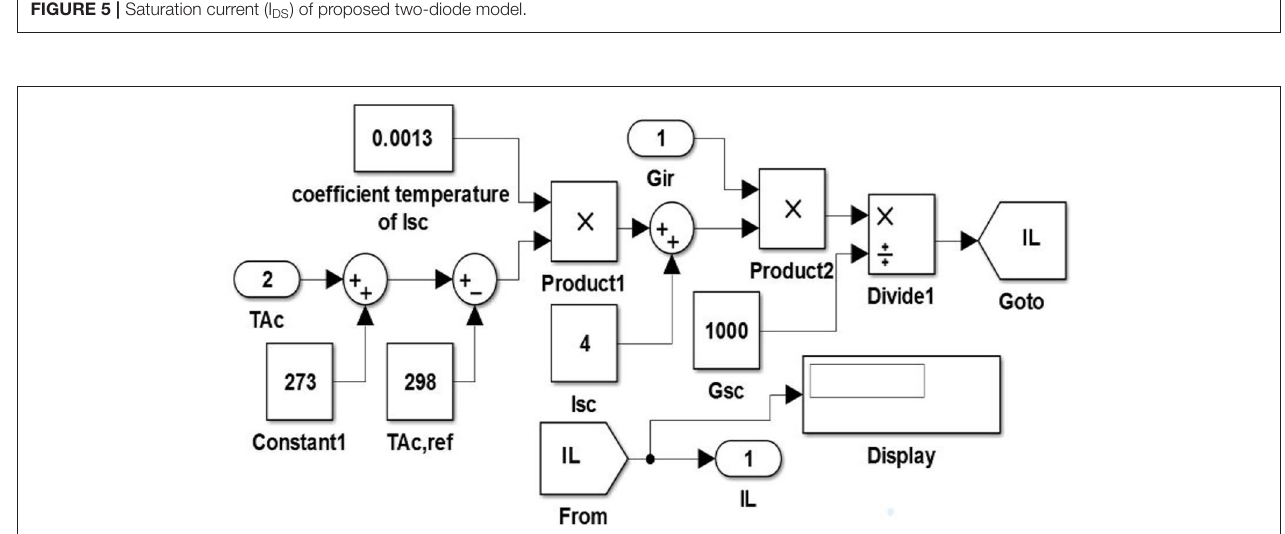
FIGURE 6 | Light current (I L ) of proposed two-diode model.